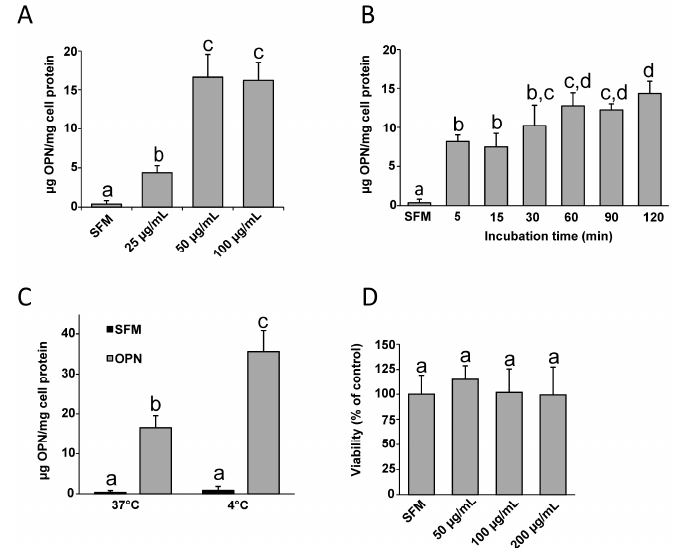
Figure 1. ELISA of intestinal Caco-2 cell lysates incubated with osteopontin (OPN). Caco-2 mono- layers were incubated with serum-free medium (SFM) or OPN, washed extensively, and lysed. The OPN content in lysates was quantified by ELISA and normalised to the total protein concentration in the lysates. ( A ) Cells incubated with OPN at the indicated concentration for 2 h. ( B ) Cells incubated with 50 µ g/mL OPN for the indicated times. ( C ) Cells incubated with SFM or OPN for 2 h at 4 ◦ C or 37 ◦ C. In ( A – C ), data are expressed as mean ± SD (n = 4) and the experiments were repeated two to three times. ( D ) Cytotoxicity of OPN was evaluated using an MTT assay. Cells were incubated with OPN (50, 100, or 200 µ g/mL) or SFM for 2 h. Data are expressed as mean ± SD (n = 10)